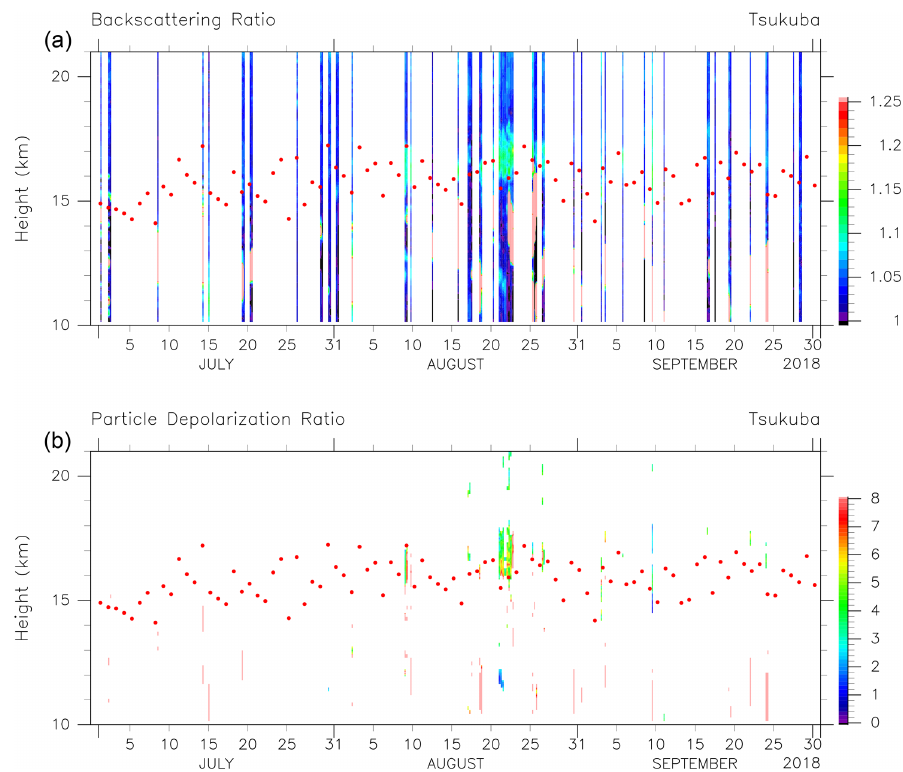
Figure 1. Time–height distributions of (a) the backscattering ratio and (b) particle depolarization ratio (%) during July–September 2018, as measured using the lidar system at MRI, Tsukuba. For each day, four time slots (i.e. 18:00–21:00, 21:00–00:00, 00:00–03:00, and 03:00– 06:00LT) are prepared, with 3h averaged data filling the slots where thick lower to middle tropospheric clouds do not exist. Red dots indicate the daily (first) lapse-rate tropopause locations determined by the Japan Meteorological Agency (JMA) based on 21:00LT radiosonde data taken at the JMA Tateno site (which shares the same site as the